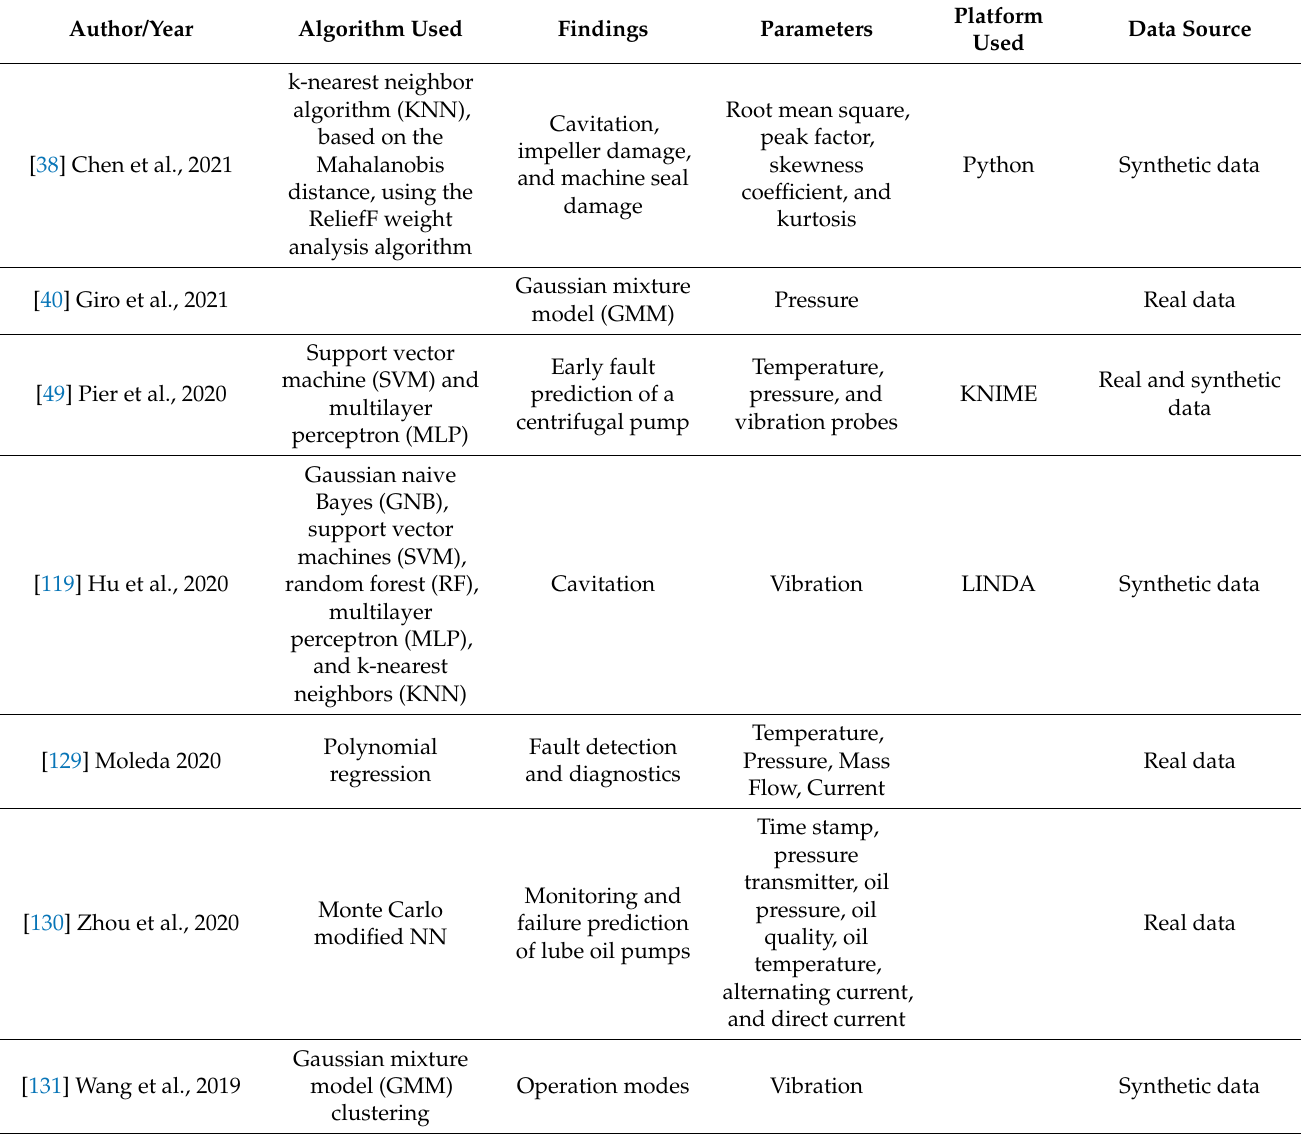
Table 8. Data used in the various